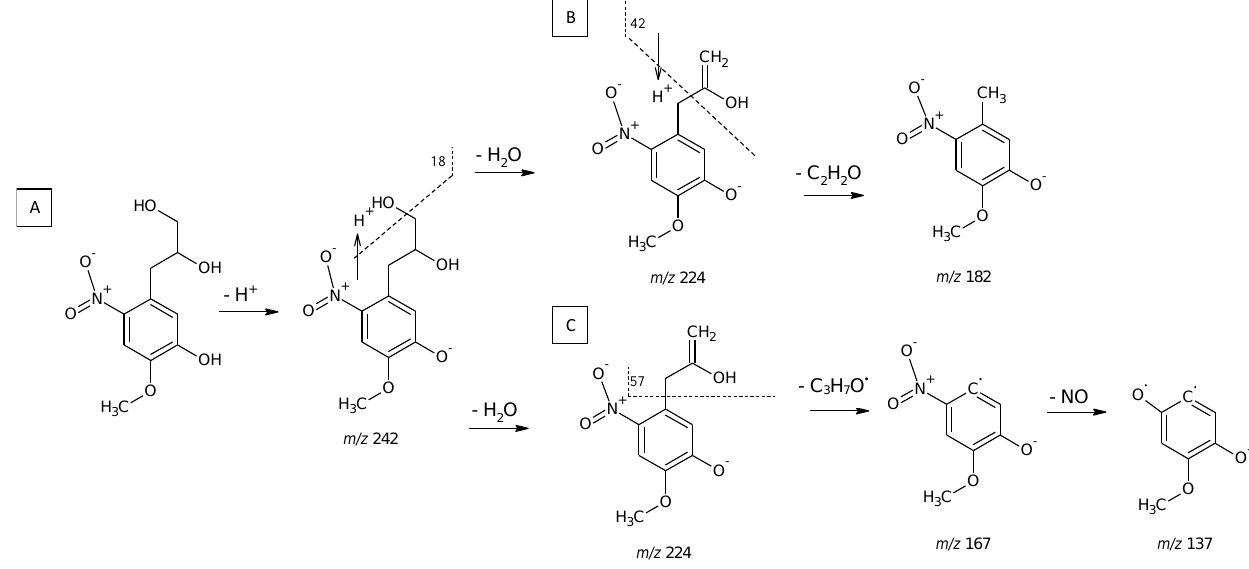
The highest intensity fragment ion is shown in bold. DBE: double bond equivalent. Electron fragmentation, EE: even electron, OE: odd electron. MF: molecular formula. ∗ DBE was manually calculated as automated DBE calculation is incorrect for radical fragment ions (DBE=5.5–0.5 (for one “hydrogen atom deficiency”)=5), see Pellegrin (1983) for the calculation of DBE and DBE correction for radical ions). ∗∗ DBE manually calculated (DBE=5–1 (for two “hydrogen atom deficiencies”)=4).